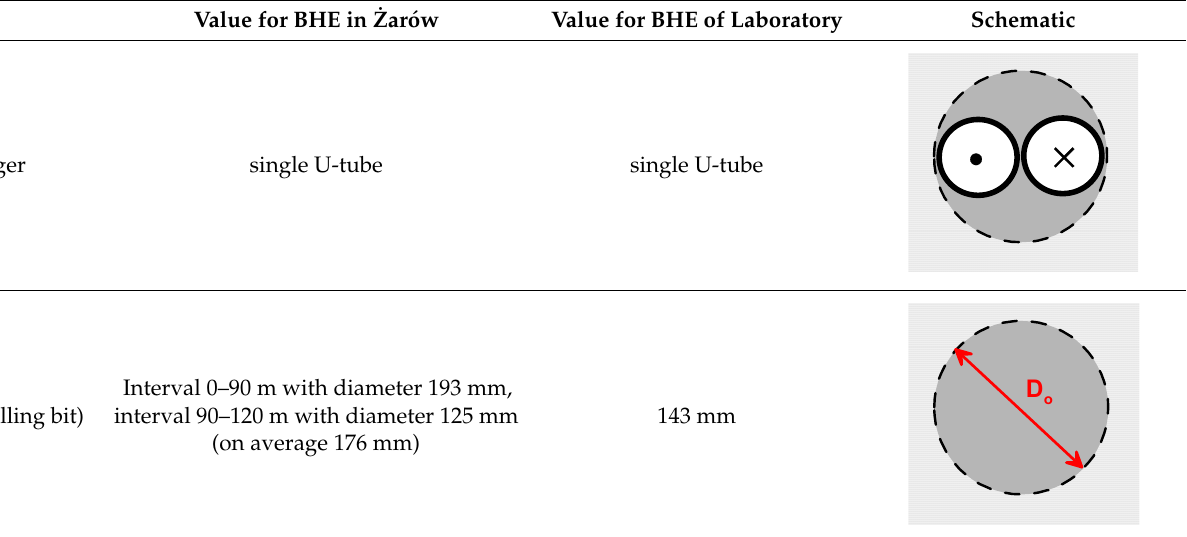
Table 2. Design of borehole heat exchanger in Ż arów and at Laboratory of Geoenergetics, Faculty of Drilling, Oil, and Gas, AGH University of Science and Technology in Krakow [51]. No.